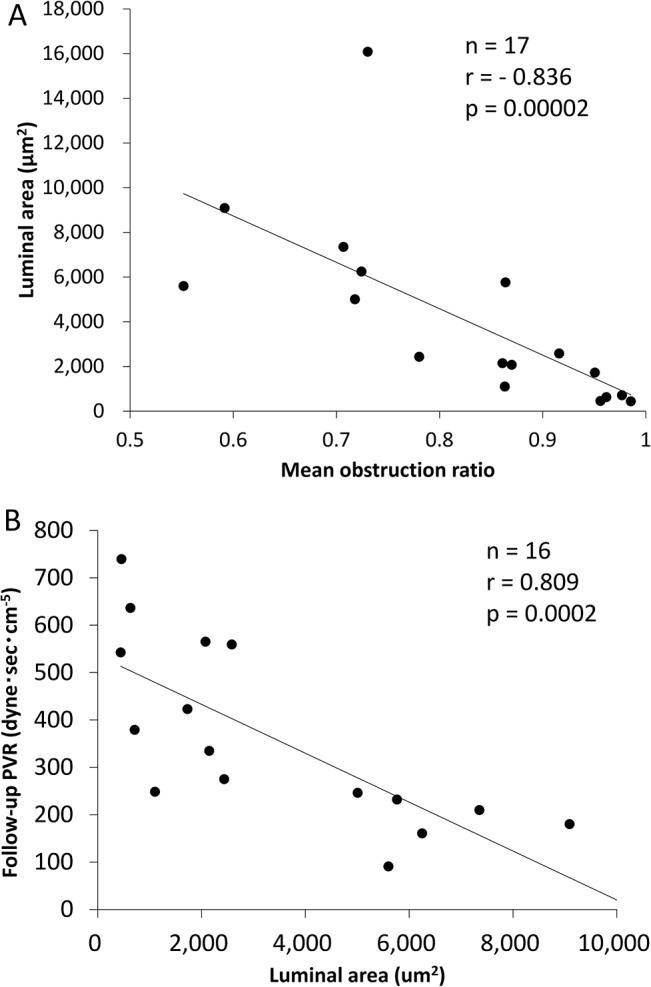
The correlations between luminal areas of the pulmonary arteries, the obstruction ratio and pulmonary vascular resistance.(A) The luminal areas of pulmonary arteries were negatively correlated with the mean obstruction ratio (n = 17, r = -0.836, p = 1.6×10−5). (B) The luminal area were negatively correlated with the follow-up pulmonary vascular resistance (PVR) (n = 16, r = -0.809, p = 0.0002).